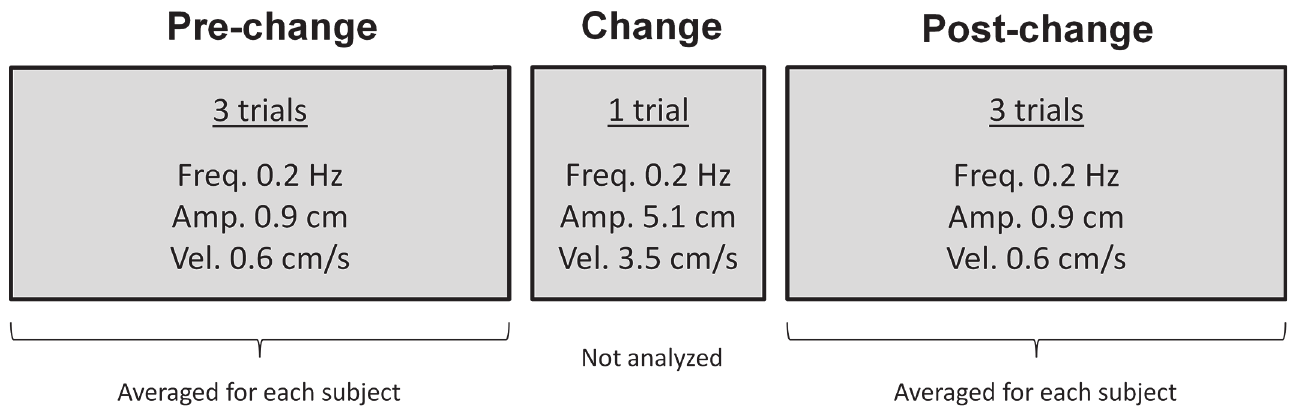
Fig 1. Schematic representation of the experimental design employed in this study. Number of trials and room movement parameters are described for pre-change, change, and post-change trials. Results for all dependent variables were averaged for each subject in the three trials of both pre- and post- change trials. Results of change trials were not included the in